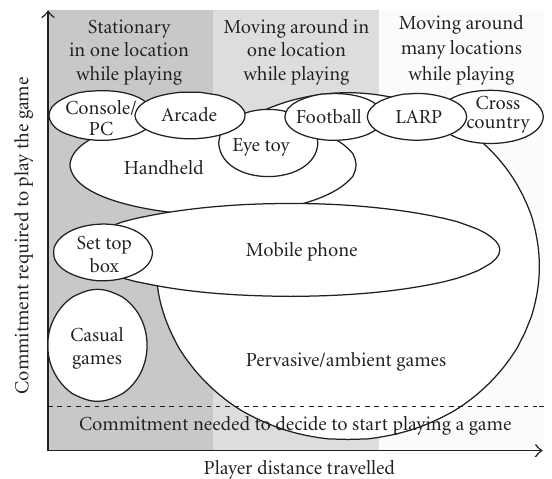
Figure 1: Commitment and movement when playing